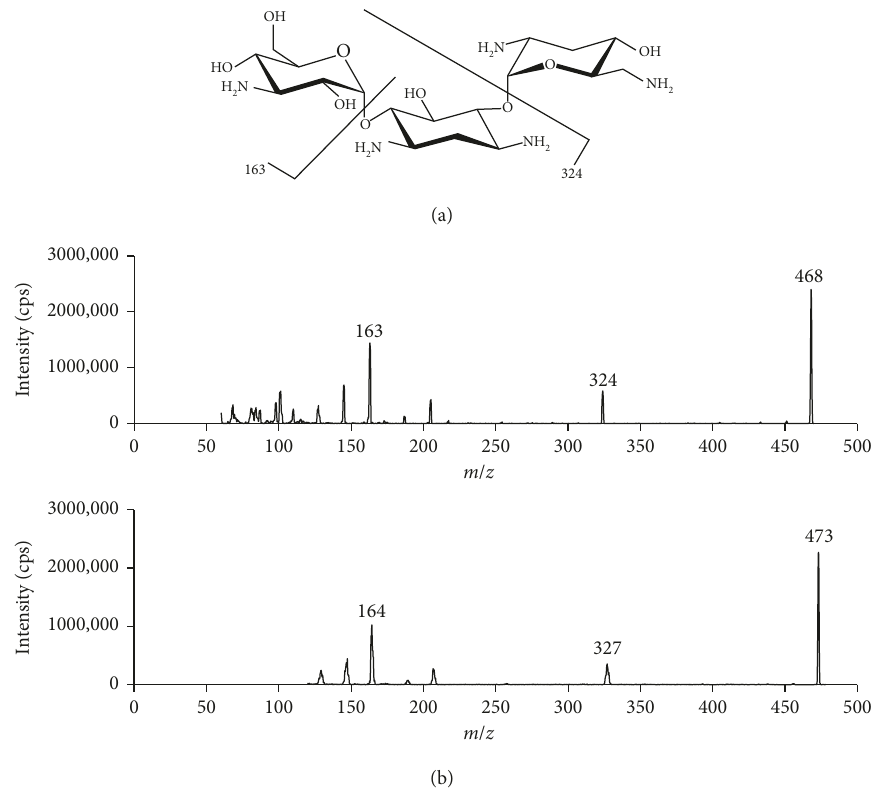
Figure 1: Product ion spectra of tobramycin (a) and deuterated tobramycin